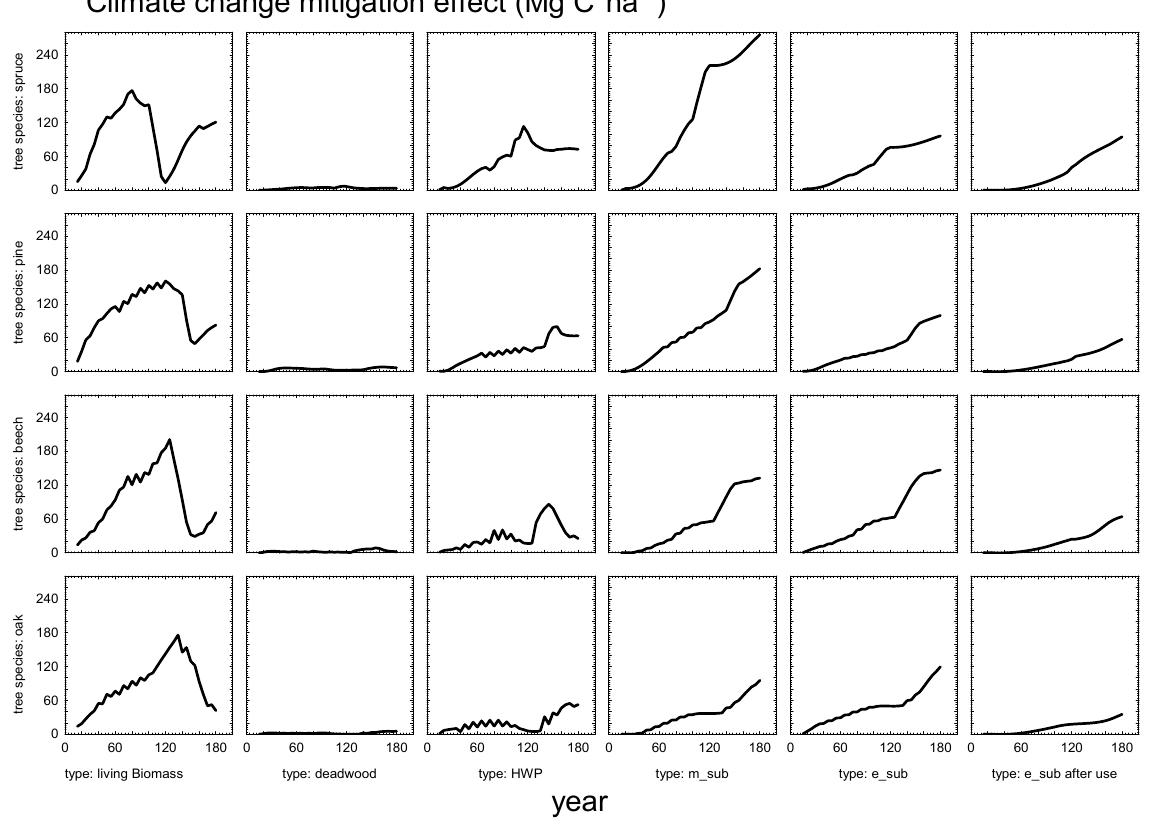
Figure 5. All climate change mitigation effects (Mg C ha − 1 ) in the managed stand for